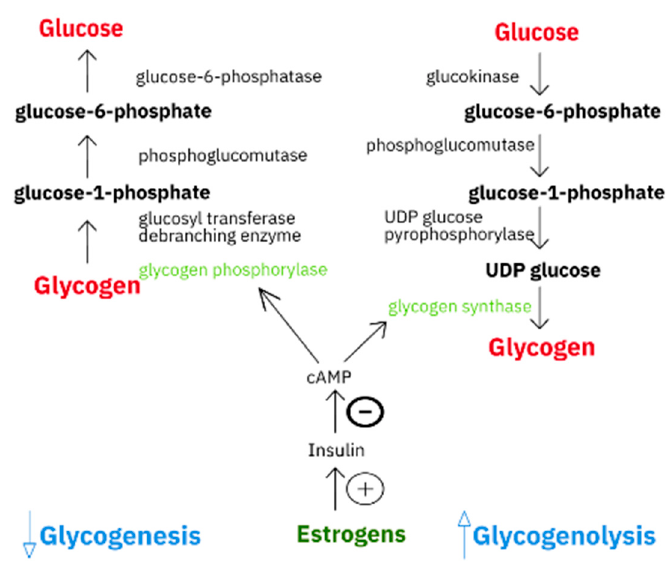
Figure 1. Graphical comparison of glycogenesis and glycogenolysis pathways.